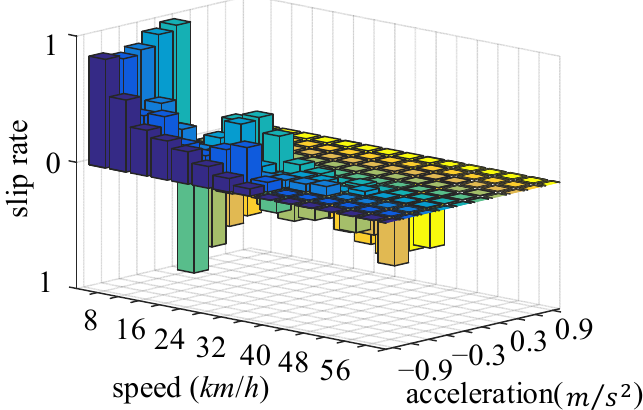
Figure 13. Database: wet asphalt matrix diagram under UDDS cycle.